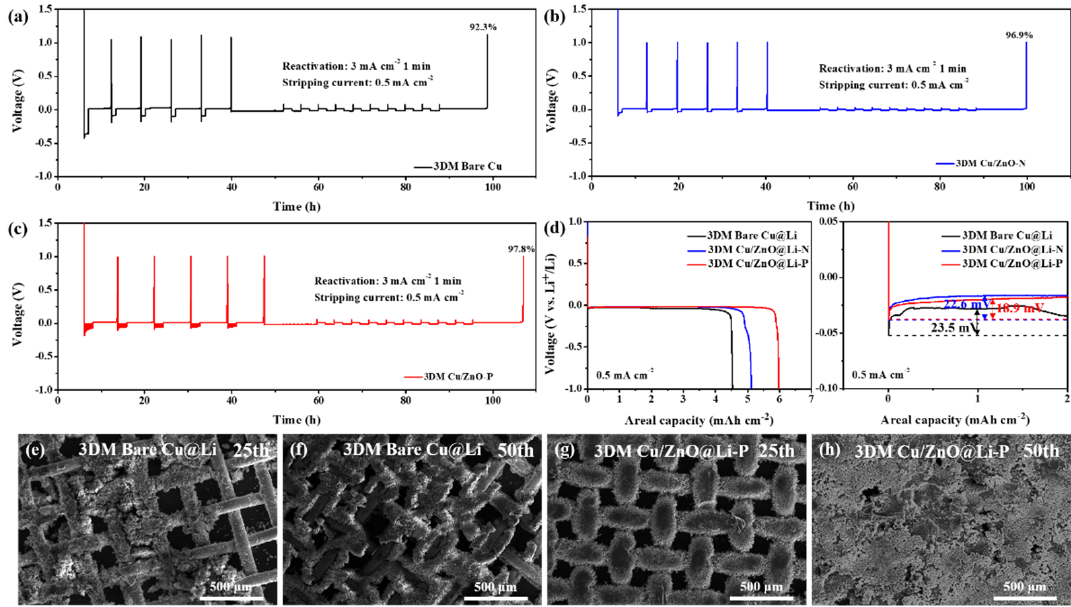
Figure 4. The CE of Li-Cu half cells with activation: ( a ) normal deposition on 3DM Bare Cu, ( b ) normal deposition on 3DM Cu/ZnO, and ( c ) pulsed current deposition on Cu/ZnO. ( d ) The specific capacity and nucleation potential of the half cells discharge at a current density of 0.5 mA cm − 2 . SEM images of ( e , f ) Cu@Li-N anode and ( g , h ) Cu/ZnO@Li-P anode after 25th and 50th cycles of lithium stripping.